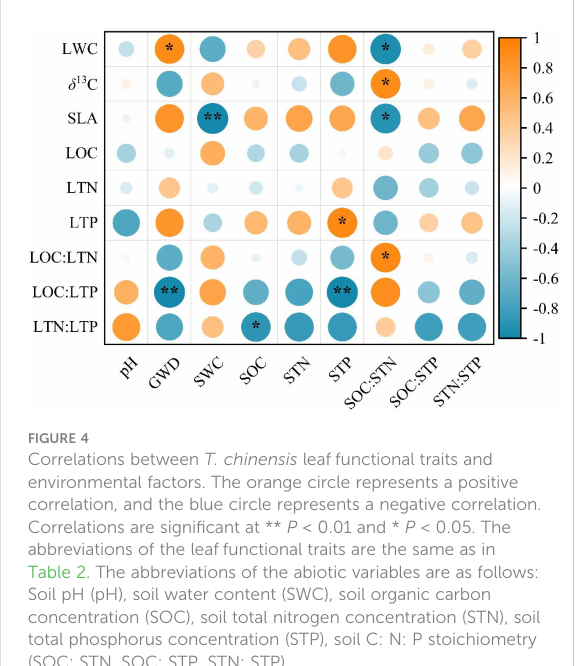
FIGURE 4 Correlations between T. chinensis leaf functional traits and environmental factors. The orange circle represents a positive correlation, and the blue circle represents a negative correlation. Correlations are signi fi cant at ** P < 0.01 and * P < 0.05. The abbreviations of the leaf functional traits are the same as in Table 2. The abbreviations of the abiotic variables are as follows: Soil pH (pH), soil water content (SWC), soil organic carbon concentration (SOC), soil total nitrogen concentration (STN), soil total phosphorus concentration (STP), soil C: N: P stoichiometry (SOC: STN, SOC: STP, STN: